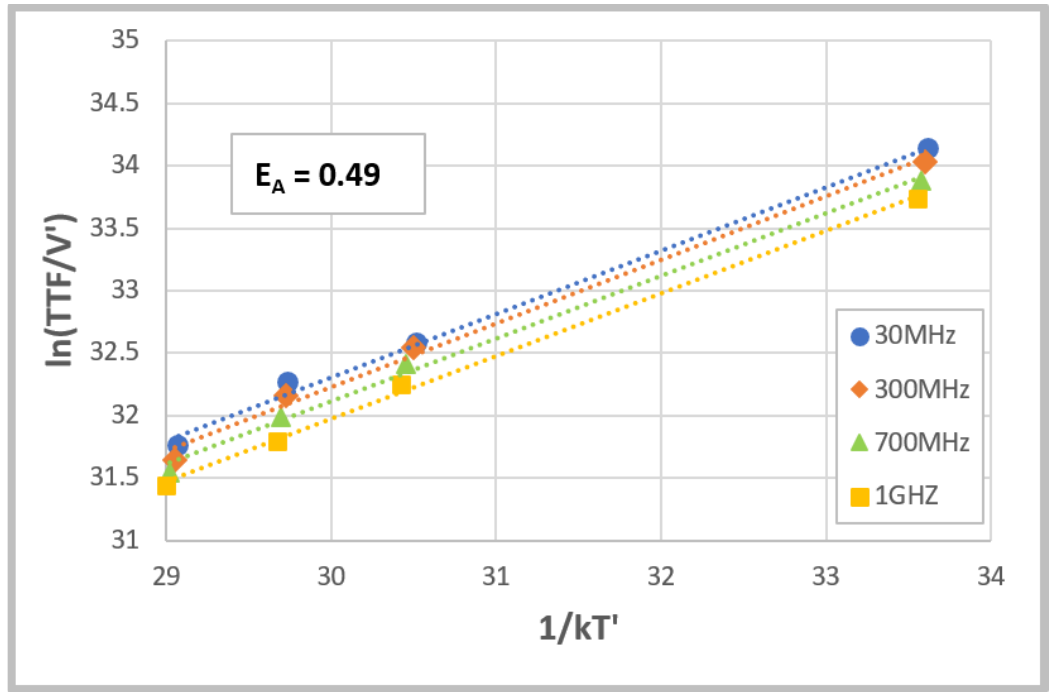
Figure 2. TTF plots of four stress modes plotted in four different frequencies: 30 MHz–1 GHz. The slopes of all the plots show an activation energy of 0.49 eV. V’ is e^(- Vγ). T’ is T + Δ T SHE .